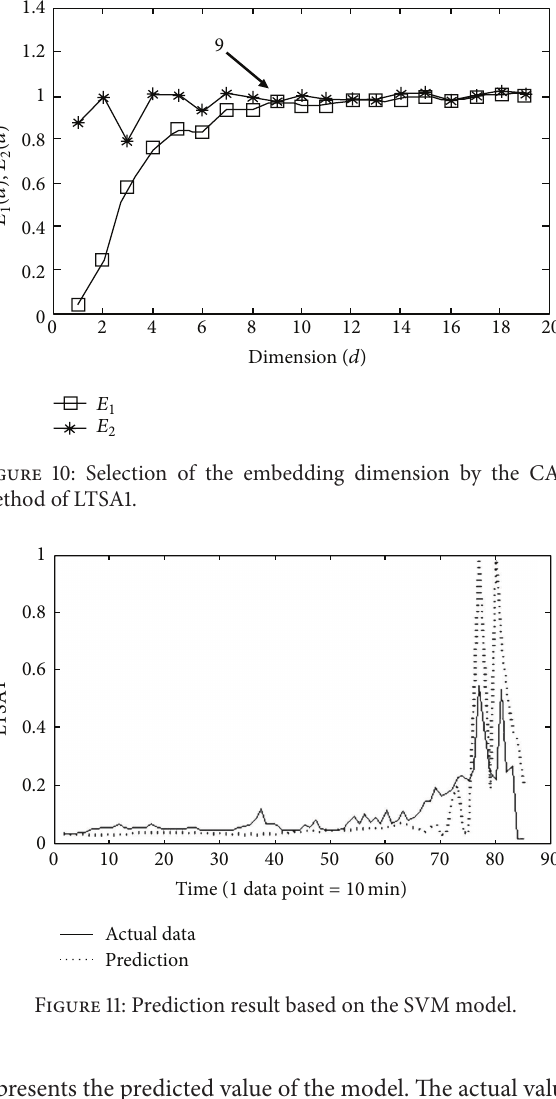
and the predicted result are shown in Figure